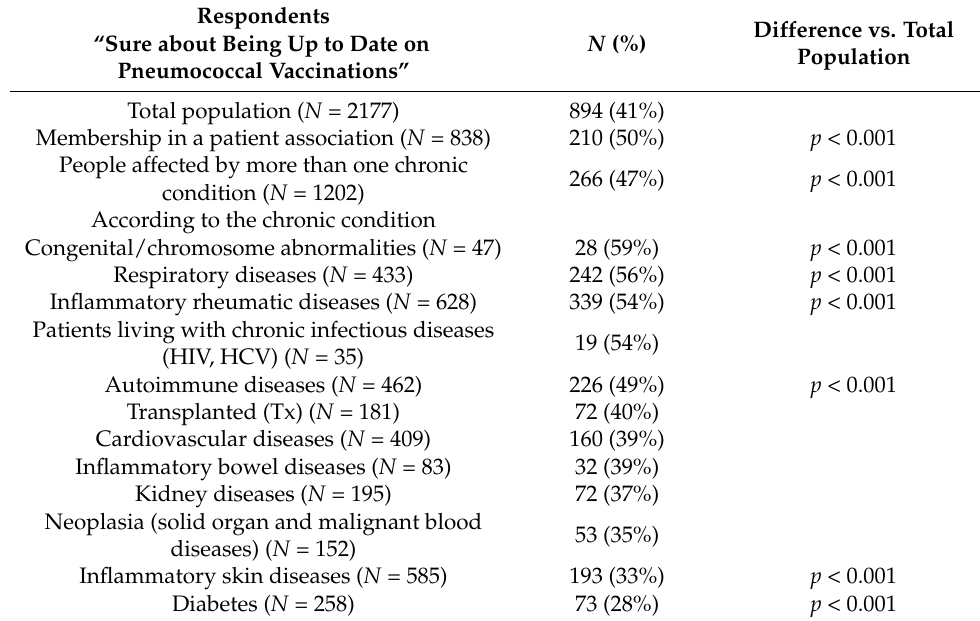
Table 3. Pneumococcal vaccination